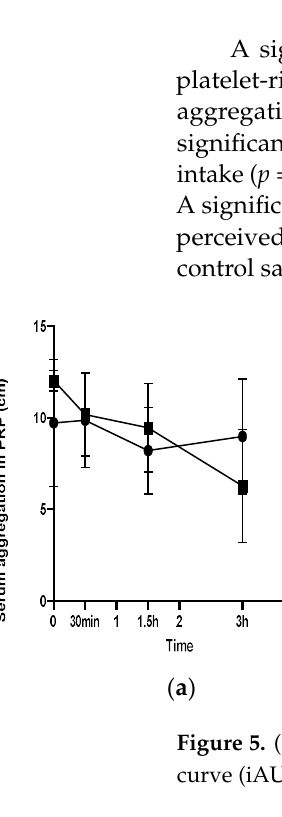
Figure 4. ( a ) Incremental changes in postprandial serum triglycerides (TG) concentration . ( b ) The incremental area under the curve (iAUC) for postprandial serum TG.